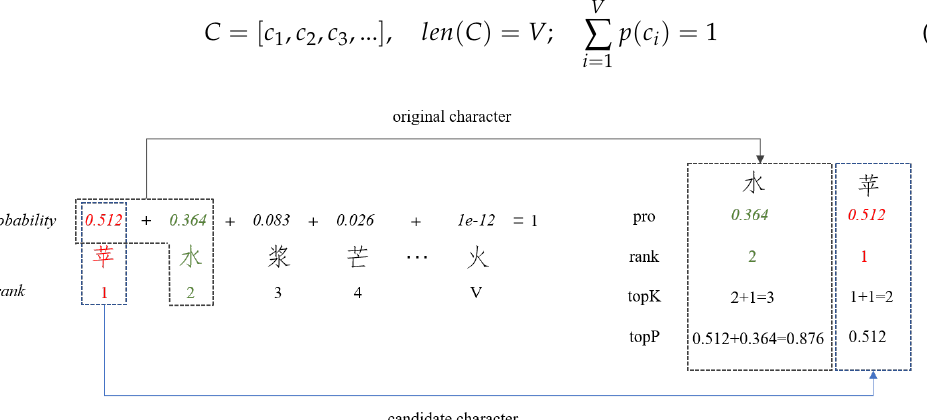
Figure 2. Across the candidate set, our approach obtains some features of 水 and 苹 : pro , rank , topK , topP